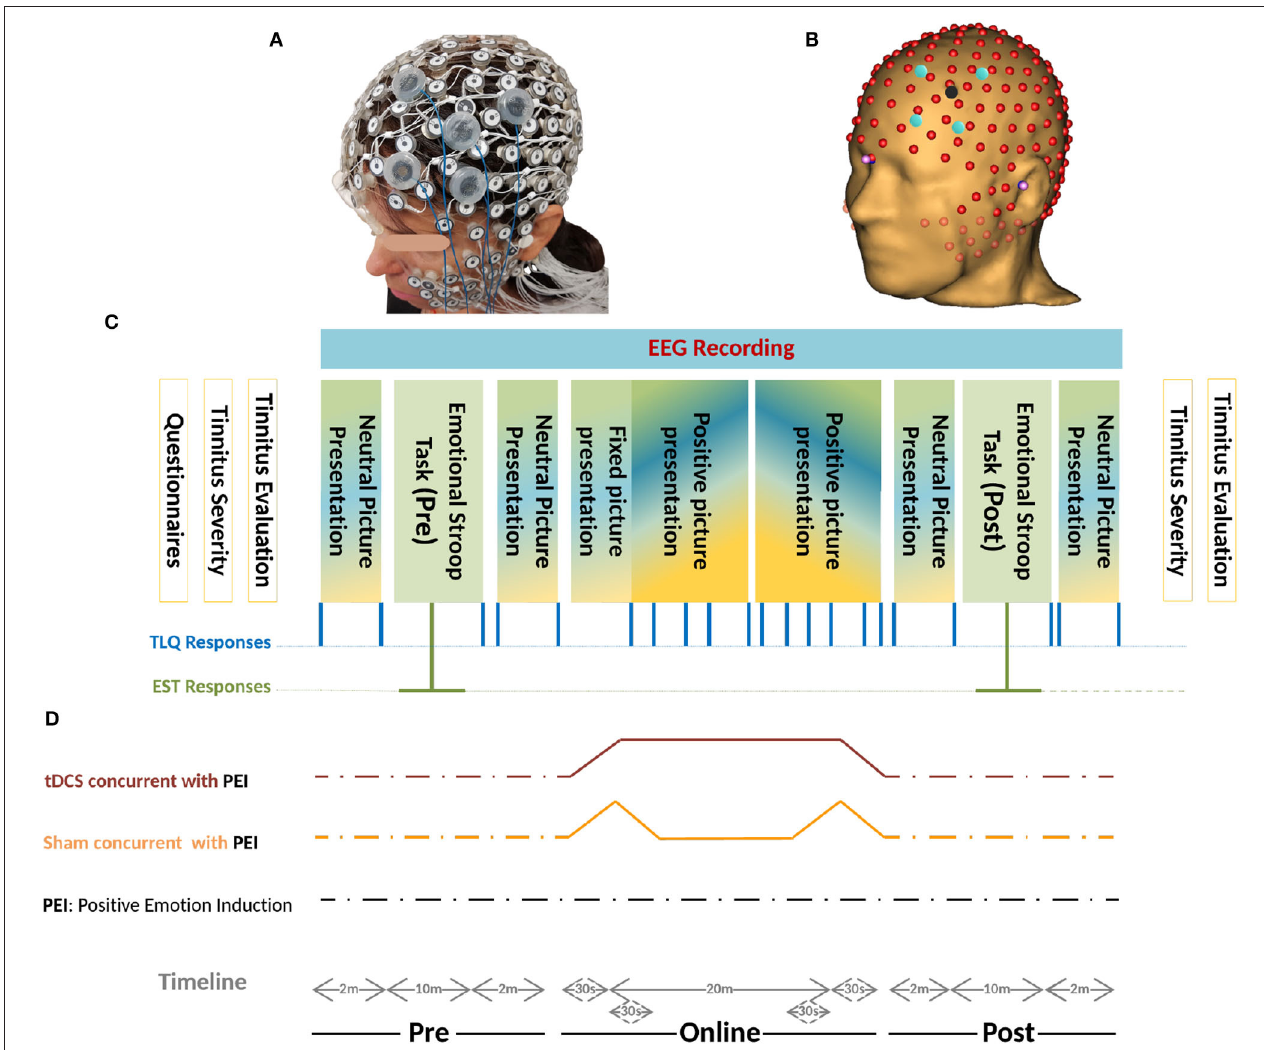
FIGURE 5 | (A) Realistic Monatge for 256-channel HydroCel Geodesic Sensor Net, and The left-dlPFC as the Region Of Interest (ROI) is also mounted in the EGI-NET. (B) Co-registered 256-channel EEG, and HD-tDCS Montage on left-dlPFC based on the MR-driven head model. The stimulation electrodes located in electrode holders were placed near the EEG channels. The electrode holder for the anode is shown in red and that for the cathode is shown in blue. The electrode holders are filled with conductive gel. (C) Schemas of the protocol. Initially, the patients filled in different questionnaires- THI, TBF-12, TS, MDI, STAI-S6, and MSQ. Before and after the experiment, psychoacoustic parameters of tinnitus together with the Tinnitus Severity questionnaire were recruited. During the experiment, two sets of pictures were presented with different Valence-ratio (Vr) and arousal-ratio (Ar) rates selected from the NAPS dataset. Neutral pictures (4 < Vr < 6 and Ar < 6) were included in four rs blocks and the positive pictures (Vr > 6) in 2 × 5 consecutive PEI blocks. Each PEI block initiates with four pictures (Vr > 6 and Ar > 6) followed by sixteen pictures (Vr > 6) randomly selected with no replacement from a one-hundred-positive-picture set ( Figure 4A ). Generally, every single block contained 20 pictures each presented for 5 s followed by a cue (+) of 500 ms . The blocks were randomized between sessions and between patients but presented in the same order within-session. The total duration of each block presentation was two min. The TLQ “Scale your tinnitus loudness from 1 − 10” was displayed 21 times, and presented in the following order: before-after each resting-state block (containing neutral pictures) and PEI block (containing positive pictures), and after each Emotional Stroop task. Throughout the experiment, the responses of TLQ and EST in blue and green lines, respectively, as well as EEG signals were all recorded via Superlab software (Cedrus Corporation, San Pedro, CA, USA). The total duration of the experiment ranged between 40 and 45 min with regard to the reaction time of patients in EST and responding to TLQ. (D) Timeline of all three sessions of study including anodal stimulation-picture presentation, sham stimulation-picture presentation, only picture presentation is illustrated. In all three sessions, the sequence of presenting pictures, TLQ, and EST are the same as those described in part C. Electrical stimulation periods (sham/Active) were illustrated in movies of Supplementary Materials